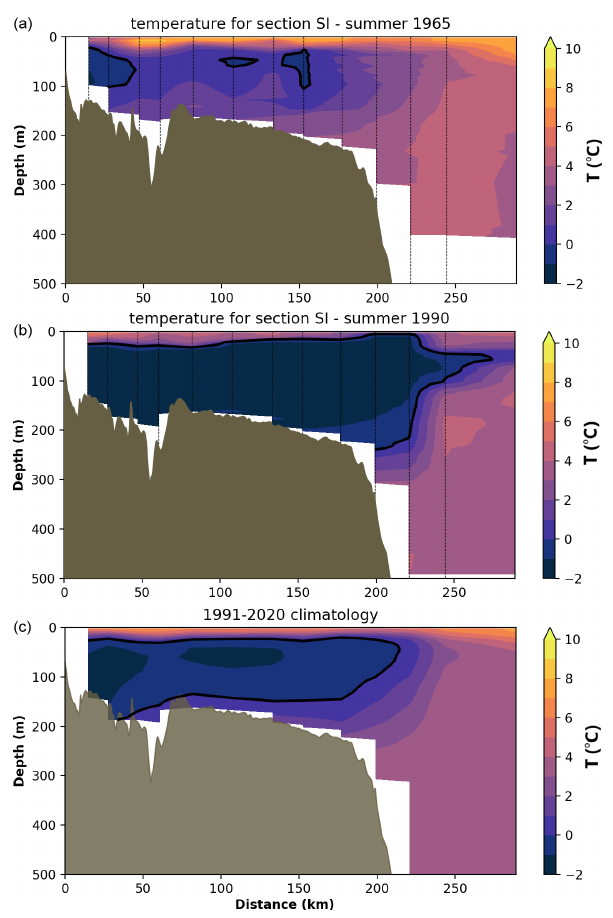
Figure 9. Summer temperature along hydrographic section Seal Is- land (SI) during 1965 (a) , 1990 (b) and the 1991–2020 average (c) . The vertical axis is limited to the top 500m, and the horizontal axis is the distance (in km) from the coast. The CIL ( T < 0 ◦ C) is high- lighted with a thick black contour. Station locations are indicated with thin dashed